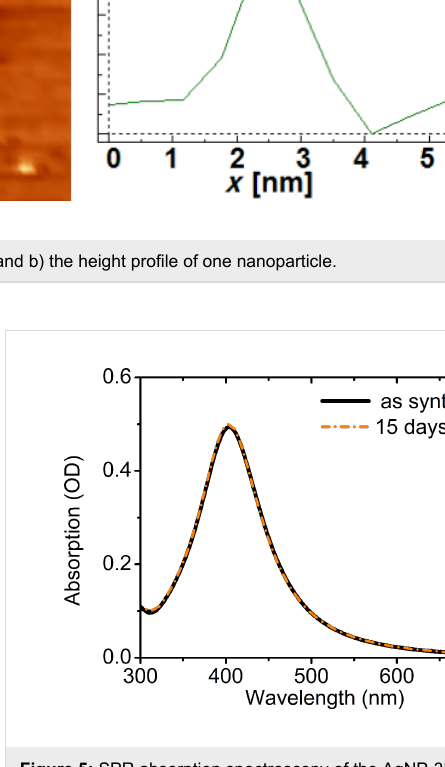
Figure 5: SPR absorption spectroscopy of the AgNP-3MPS solution (synthesis b) taken immediately after the synthesis and after 15 days, indicating good long term stability.